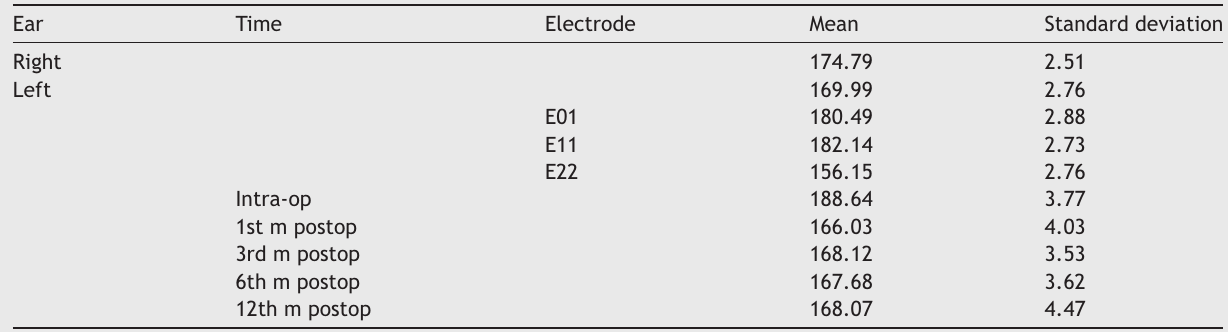
Mean (current units) and standard deviation per